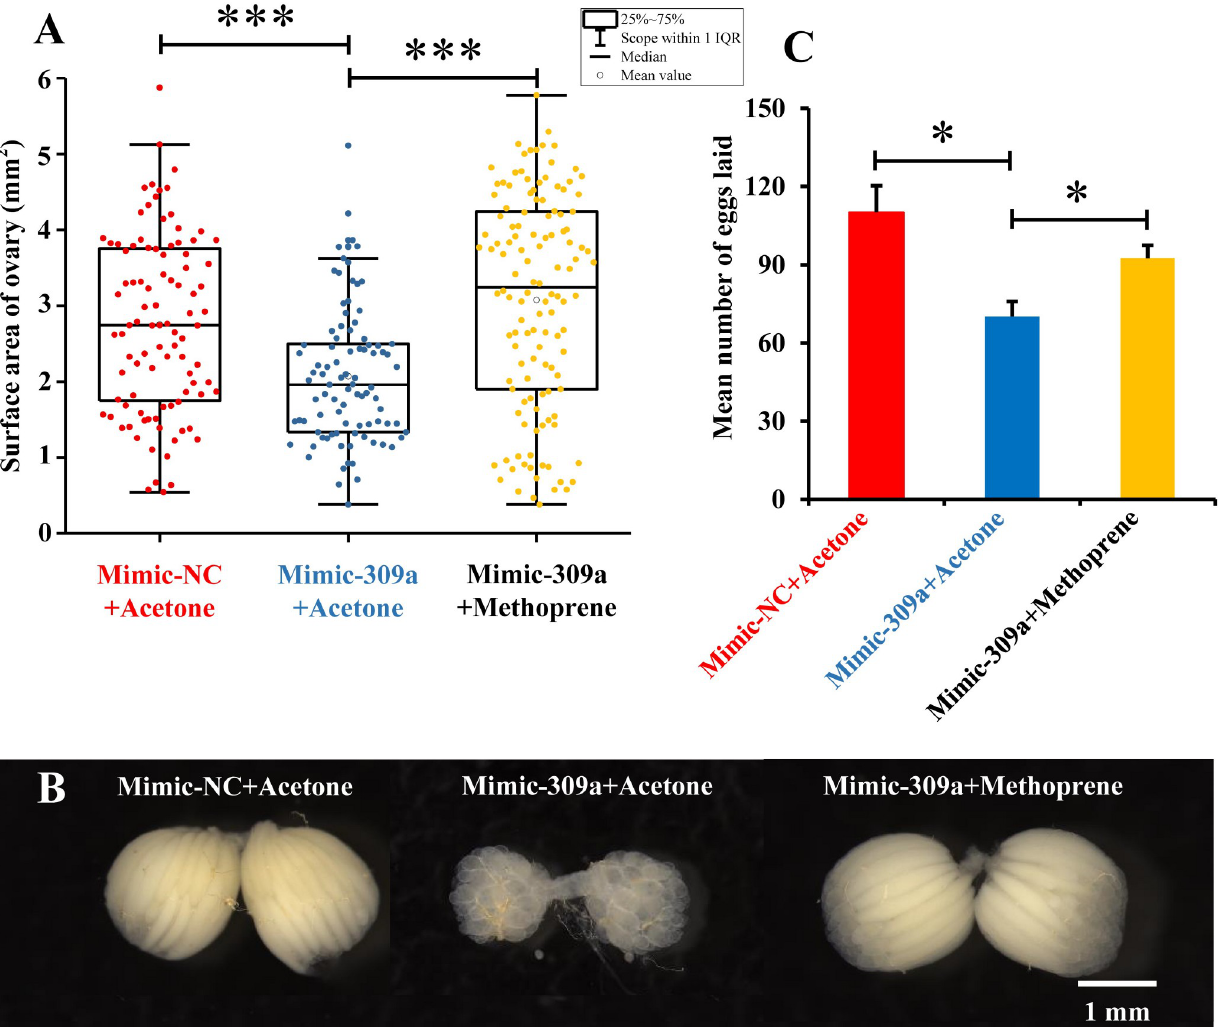
Fig 8. Effects of methoprene treatment on ovarian development in miR-309a overexpressed female adults of B . dorsalis . (A) Surface area of the ovary, including the mimic-NC-injected females with acetone treatment (mimic-NC+acetone, n = 96), mimic-309a-injected females with acetone treatment (mimic-309a+acetone, n = 91), and mimic-309a-injected females with methoprene treatment (mimic-309a+methoprene, n = 126). (B) Egg number. The fecundity of miR-309a-overexpressed females in methoprene treatment after successfully mating with untreated naive males. (C) Ovary phenotypes. Data are means ± SE (error bars) of three biological replications. The differences were analyzed by Student’s t test. For the significance test: � P < 0.05, ��� P < 0.001.